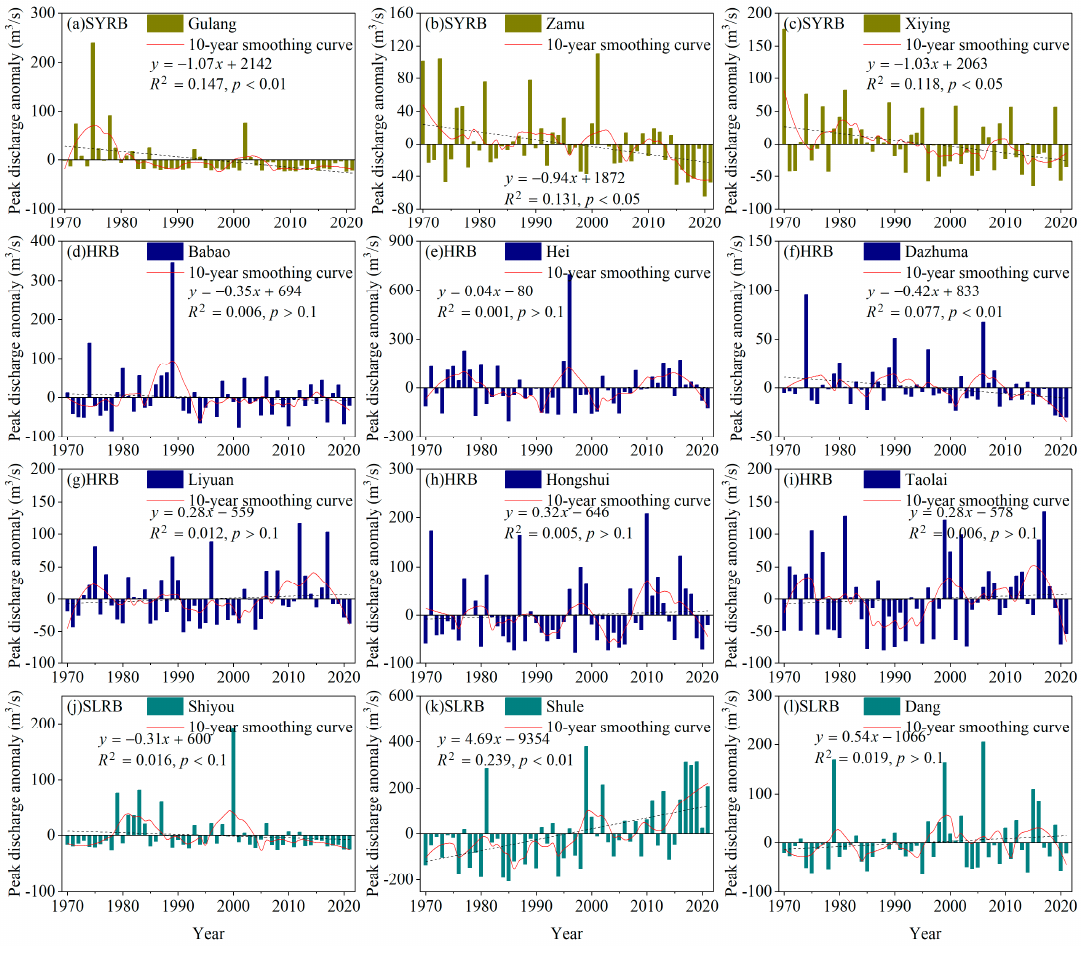
Figure 2. Trends of AMPD for 12 representative rivers in the QM region, northwest China. ( a − c ) Gulang, Zamu, and Xiying rivers in SYRB, ( d − i ) Babao, Hei, Dazhuma, Liyuan, Hongshui, and Tao- lai rivers in HRB, ( j − l ) Shiyou, Shule, and Dang rivers in SLRB, respectively. Table 4. Results of trend analysis of AMPD and POT3M series, in the QM region, northwest China. River Mean Value Code AMPD Series Basin (m 3